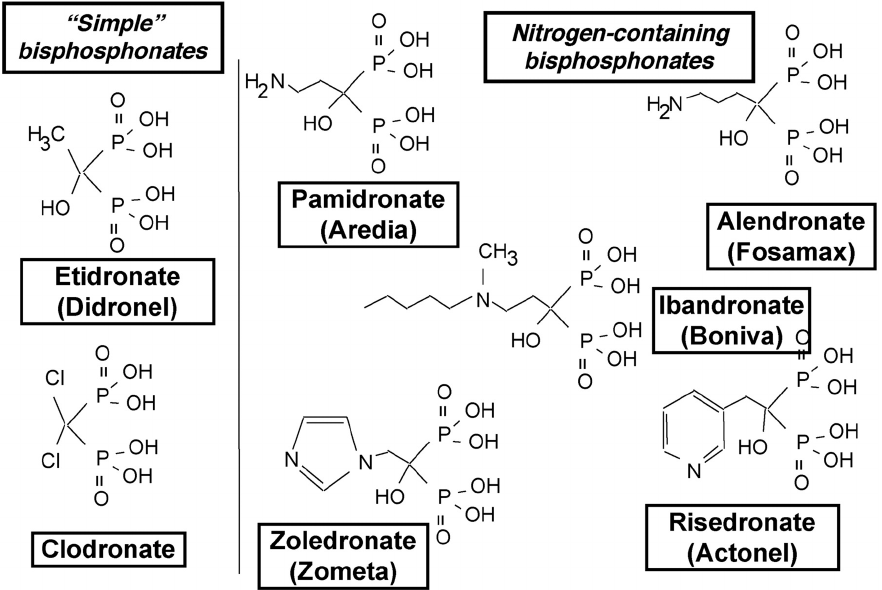
Figure 4. Structures of the N-aminobisphosphonates [78]. These drugs are analogs of inorganic pyrophosphate, a major constituent of the bone mineral matrix. When osteoclasts take up the bone mineral matrix, the n-amino bisphosphonates inhibit farnesyl diphosphate synthase, responsible for converting dimethylallyl diphosphate to farnesyl diphosphate (FDP). Thus, leading to the inhibition of the post-translational modifications (or isoprenylation) of guanosine triphosphate (GTP)-binding proteins Rab, Rac, and Rho. These GTP binding proteins are critical for osteoclast resorption of bone.